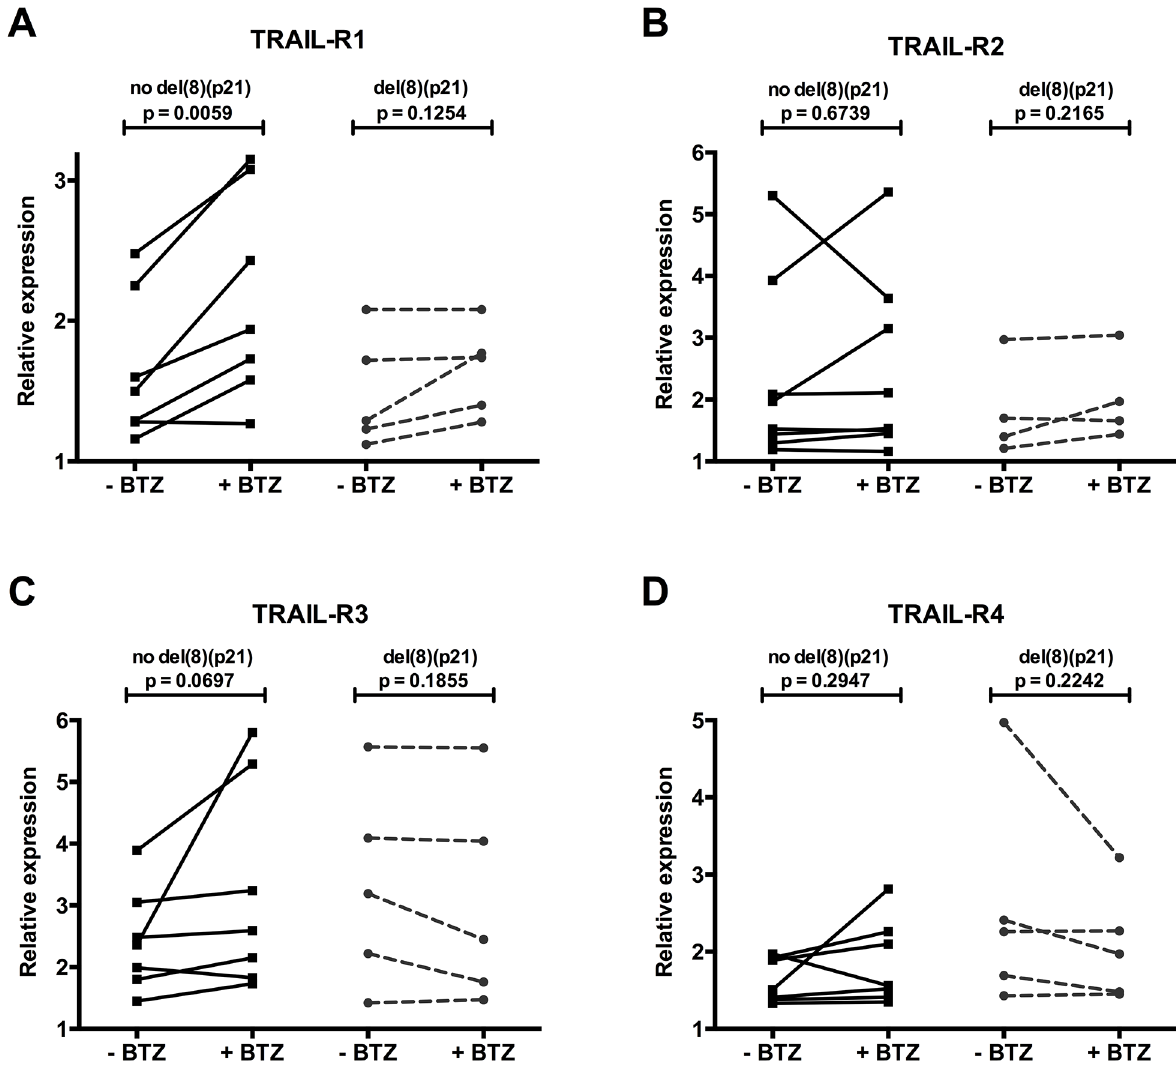
Fig 3. Patients with del(8)(p21) fail to upregulate pro-apoptotic TRAIL receptor expression upon bortezomib treatment. Relative expression of TRAIL receptors of 5 MM patients with del(8)(p21) and 7 MM patients without deletion is determined by flow cytometry. Cell surface Expression levels are normalized to corresponding isotype controls. (A) TRAIL-R1, (B) TRAIL-R2, (C) TRAIL-R3, (D) TRAIL-R4. Effect of bortezomib treatment on TRAIL receptor expression is analyzed by paired